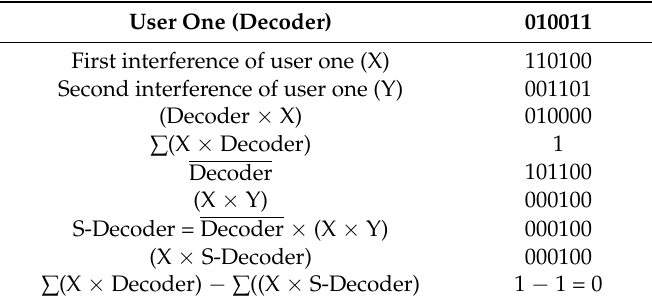
Figure 1. Single photodiode (SPD) detection. Table 1. Logical interference